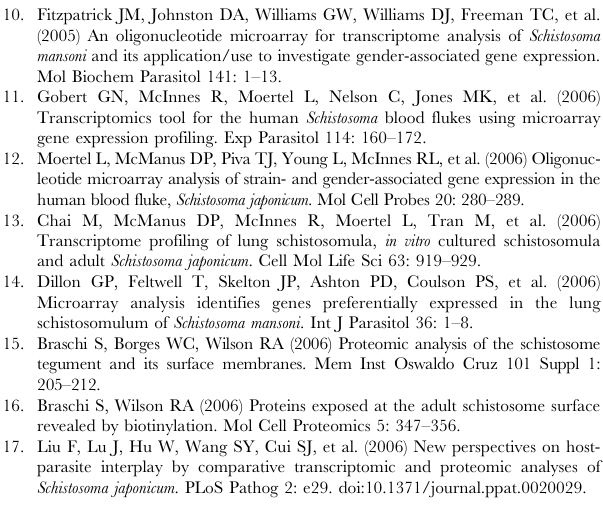
tissues. The number of probes in each gene ontology is noted. Figure S2 Principal Component Analysis of the 7,623 flag filtered genes showing the gene expression profile of control, gastrodermis (gut), ovary and vitellaria of female S. japonicum. Found at: doi:10.1371/journal.pntd.0000469.s002 (0.08 MB TIF) Table S1 Complete lists of contiguous sequences listed in the custom designed schistosome microarray manufactured by Agilent Technologies used in this study. Column A (ProbeID): Unique identifier of probe on the microarray. Column B (Sequence): Nucleotide sequence of the 60mer probe. Column C (EST Sequence): Complete nucleotide sequence of the assembled EST contig. Column D (TargetID): Contig designation for either S. japonicum (Contig) or S. mansoni (TC). Column E (Accessions): Genbank accession number corresponding to the EST sequences. Column F (Description-Nucleotide): BLASTn annotation result based on nucleotide sequence. Column G (GeneSymbols): Designation of primary or secondary probe design to the corresponding contig. Column H (Protein Homology): BLASTX annotation result based on protein sequence. Column G (Gene Ontology): Gene Ontology number and description.